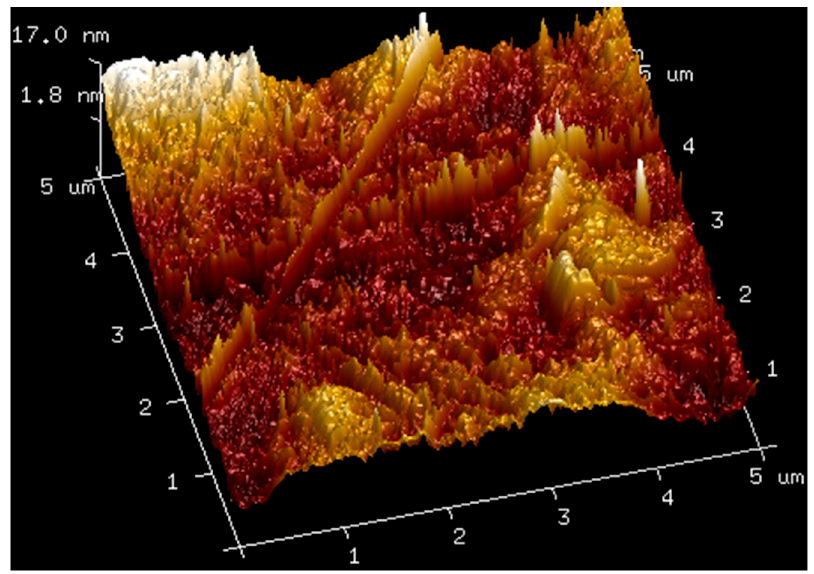
Figure 4. AFM visualization of the surface of film obtained from the solution of 1.5% high-molecular HA.